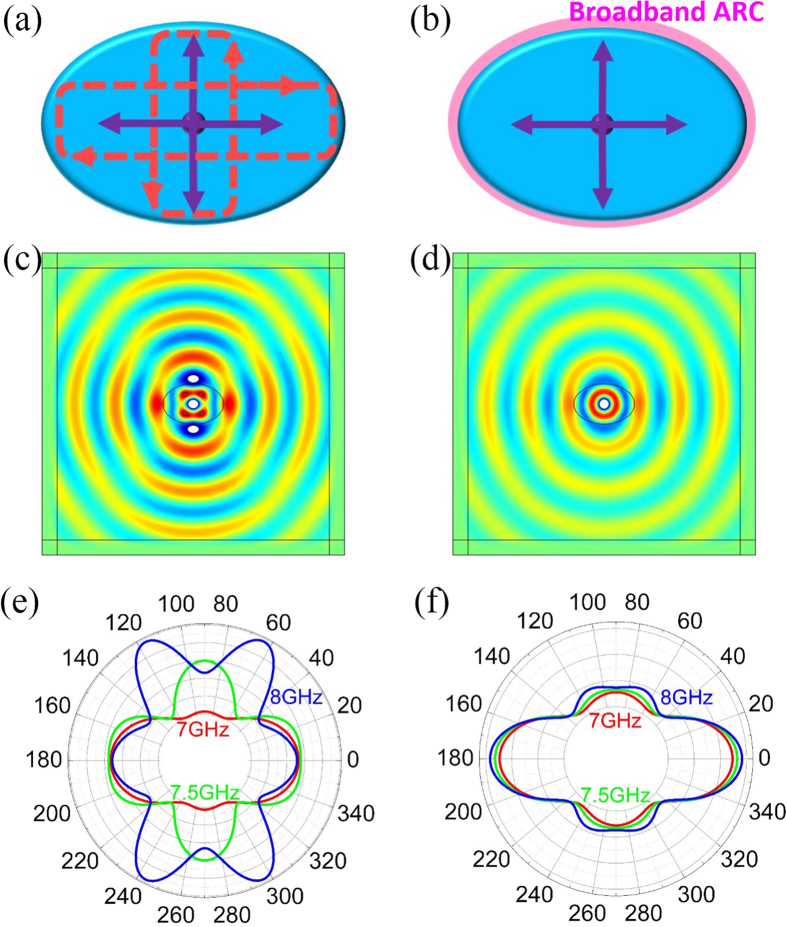
An example of application in antenna design.Schematic of the electric monopole antenna with an elliptically shaped dielectric shell when the conductive ARC is (a) uncoated and (b) coated. Snapshot of electric fields produced by the antenna at the 7.5 GHz (c) without and (d) with the conductive ARC. Far-field patterns of electric fields at 7 GHz, 7.5 GHz and 8 GHz (e) without and (f) with the conductive ARC.